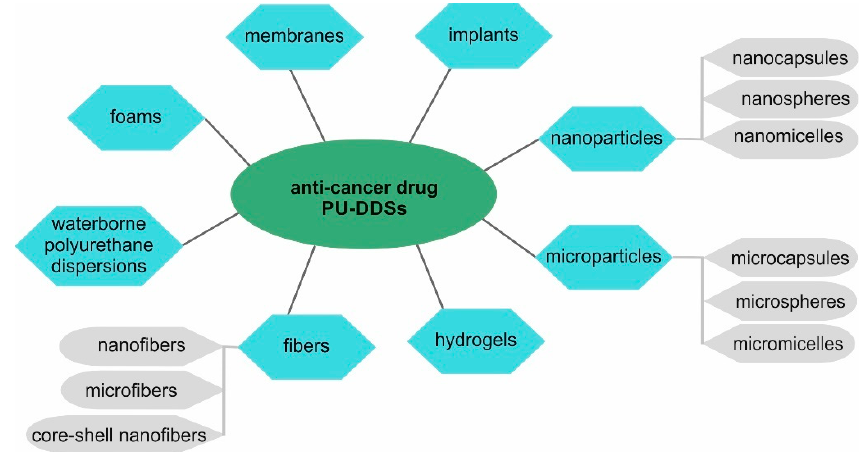
Figure 4. Anti-cancer drugs used in the technology for polyurethane drug delivery systems.